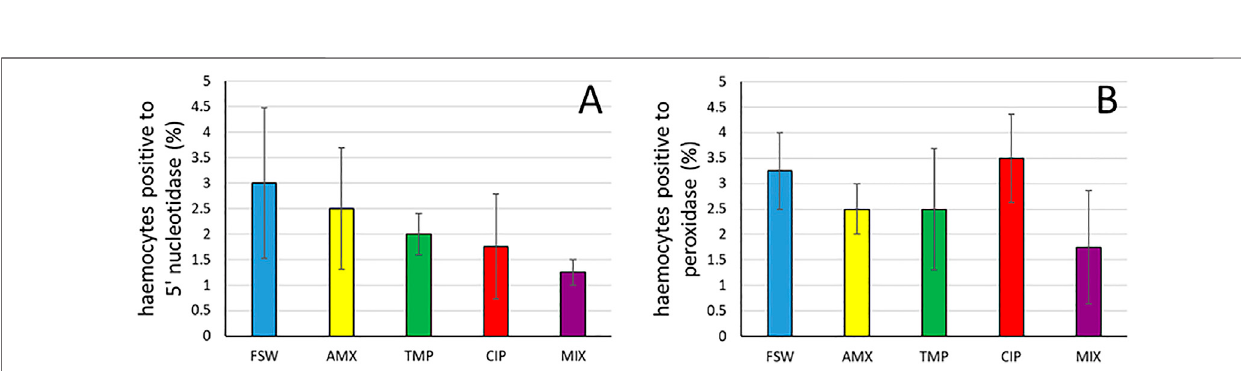
Frontiers in Environmental Science |